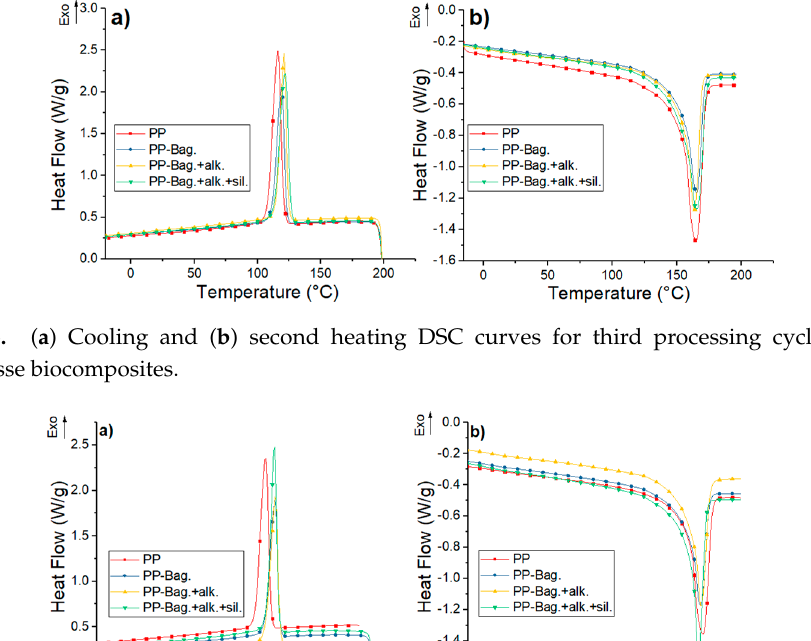
Figure 4. ( a ) Cooling and ( b ) second heating DSC curves for first processing cycle PP and PP-Bagasse biocomposites.